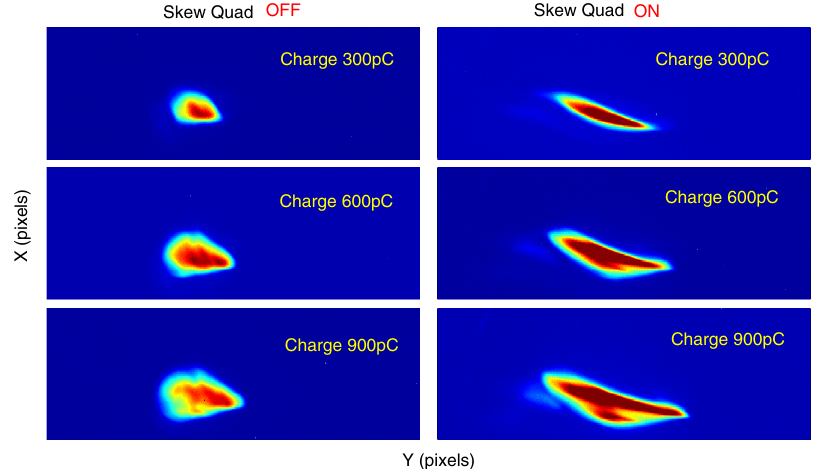
FIG. 11. Measured transverse beam profile at X24 as a function of skew quadrupole off (left column) and skew quadrupole on (right column) for various charges. The CSR bulge effect is prominent at higher charges. The image is rotated by 90 (cid:5) compared to Fig. 10. When the skew quadrupole is turned on, the y axis on the right is proportional to the incoming bunch length and the x axis proportional to the energy. Each image is 600 pixels (cid:8) 150 pixels with each pixel measuring 32.8 microns.